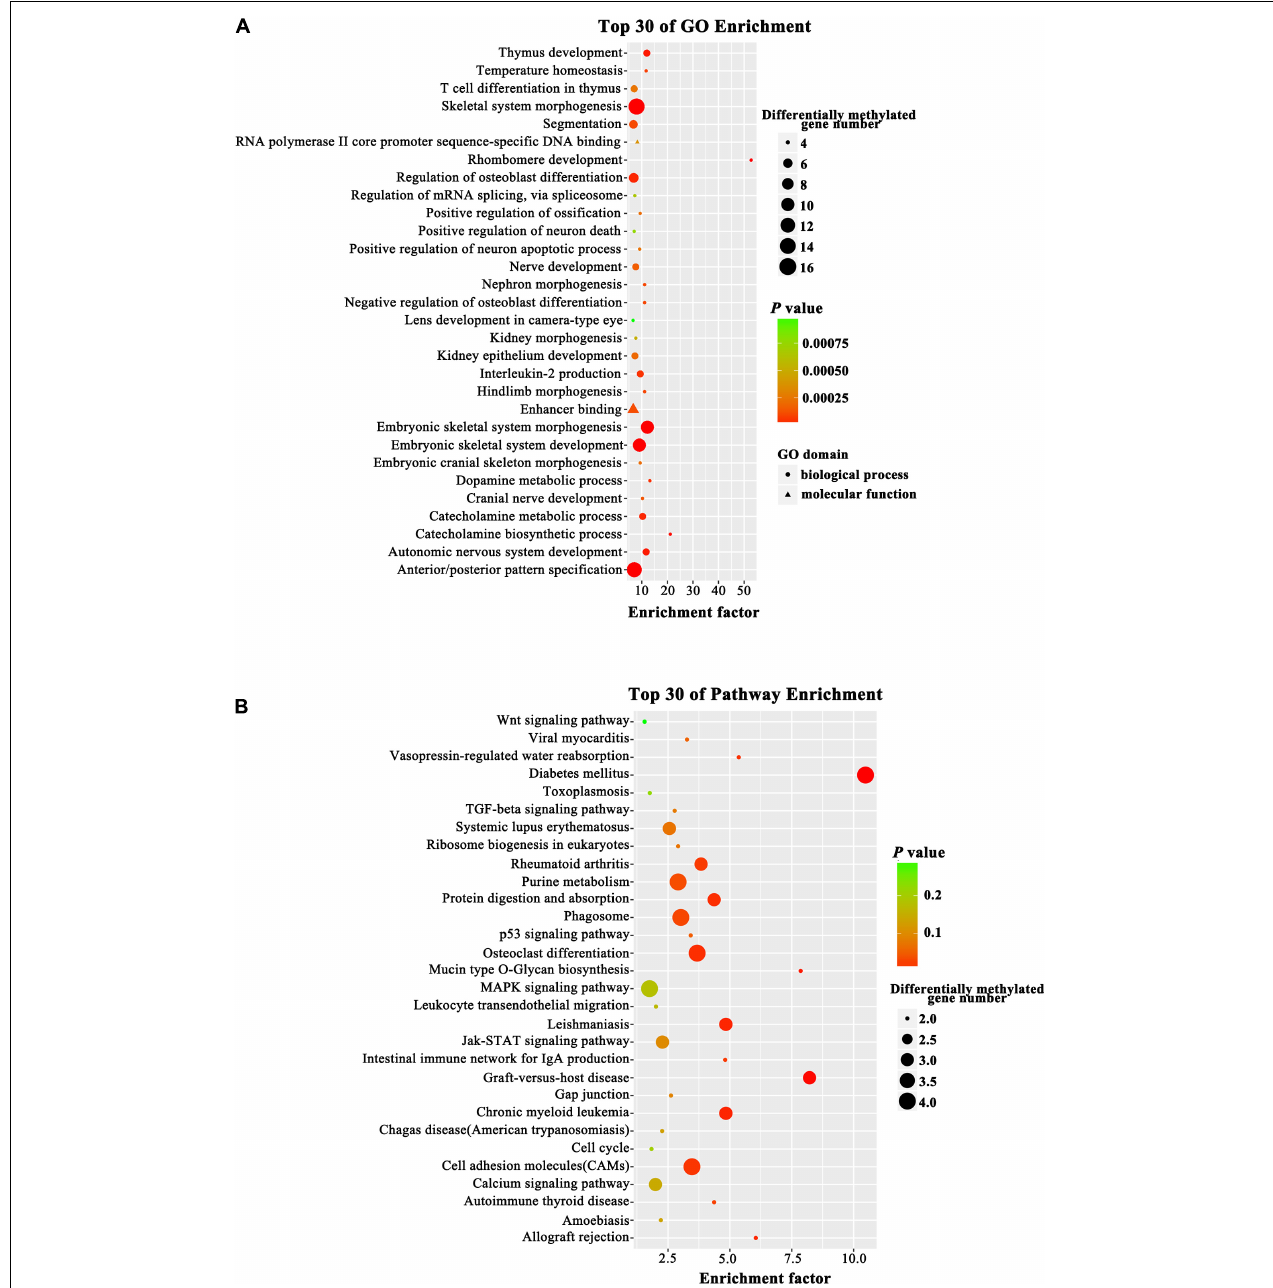
FIGURE 5 | Top GO and KEGG pathway analyses of CG type DMRs. (A) Top GO analysis. The enrichment factor indicates the ratio of the differentially methylated gene number to the total gene number in a certain pathway. The size of each circle represents the number of genes contained in the particular class; a larger circle indicates a larger number of genes. The color indicates the P -value (green higher, red lower). Circles and triangles indicate biological process and molecular function, respectively. (B) Top KEGG analysis. The enrichment factor indicates the ratio of the differentially methylated gene number to the total gene number in a certain pathway. The size of each circle represents the number of genes contained in the particular class; a larger circle indicates a larger number of genes. The color indicates the P -value (green higher, red